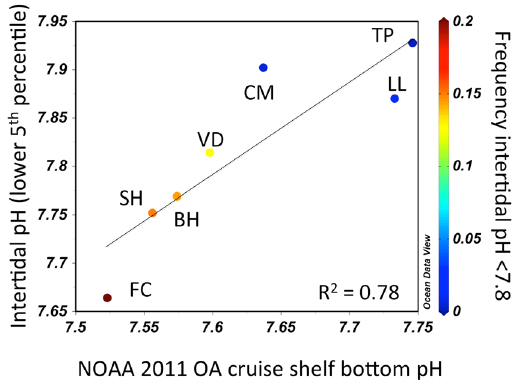
Figure 4. Correlation between point-in-time measurement of off-shore (water depth range of 60 to 125 m) near-bottom pH in 2011 from the (x-axis) and intertidal measurements of seasonal severity (lower 5 th percentile, left y-axis) and frequency (% observations with pH < 7.8, denoted by symbol color and color bar) of low pH conditions. For station locations, refer to Table S1.